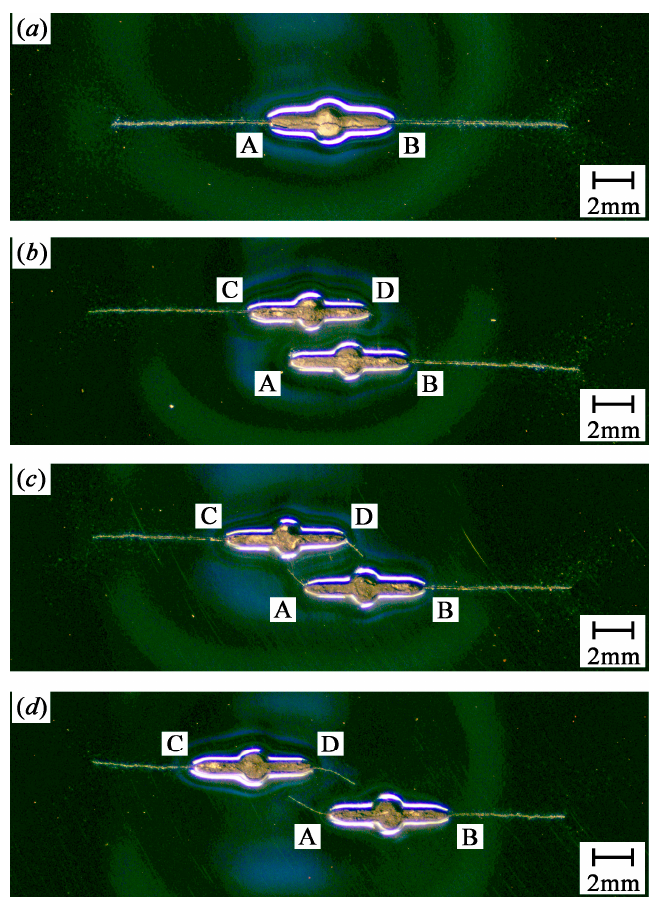
Figure 2. Crack growth paths for different specimens: ( a ) SC, ( b ) PC1.0s2, ( c ) PC1.0s4, and ( d ) PC1.0s7.